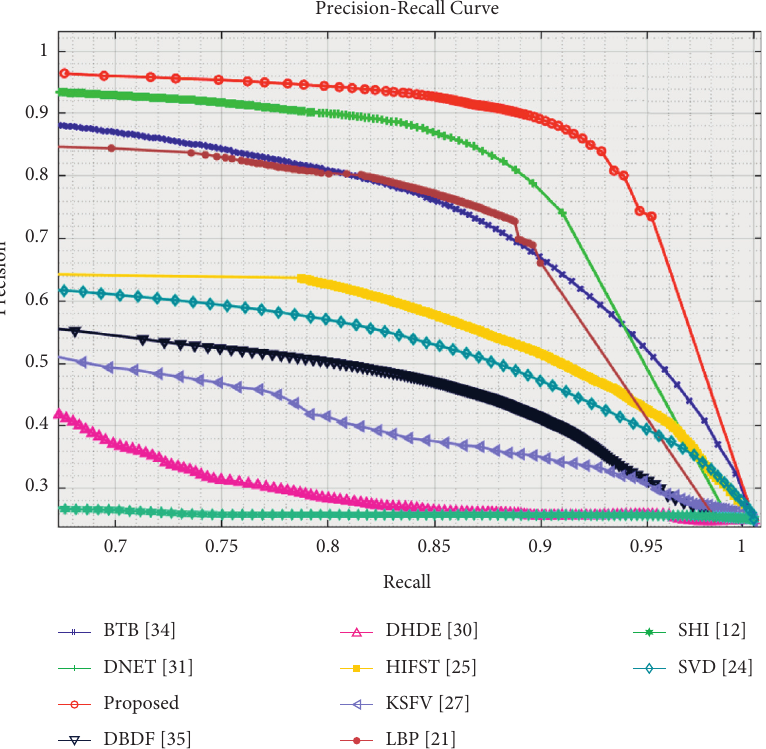
Figure 8: PR curve comparison on the DUT dataset.